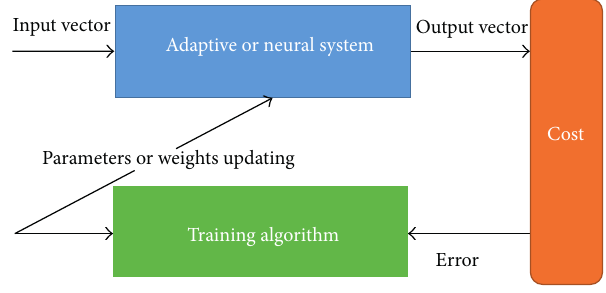
Figure 3: Adaptive or neural system’s